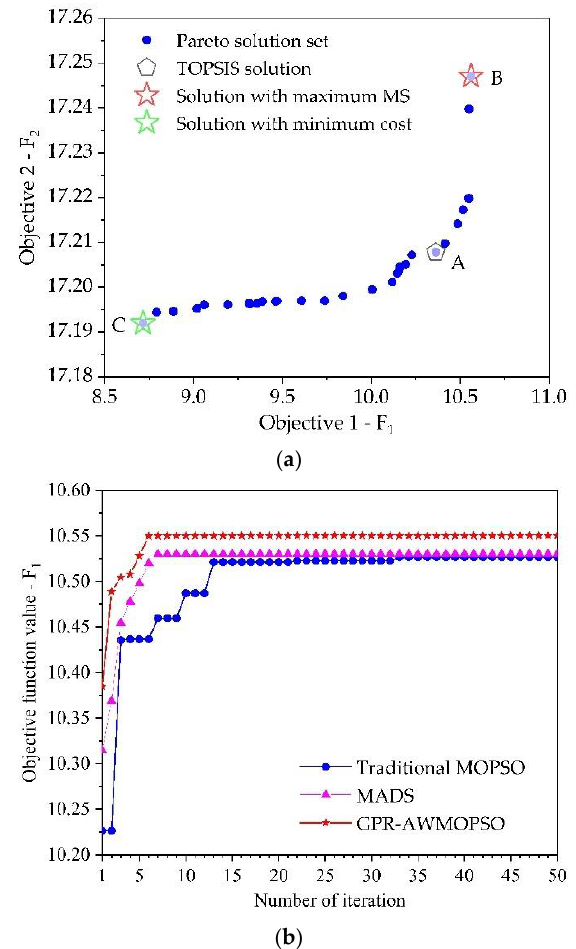
Figure 7. The proportion optimization results for basalt fibre modified asphalt mixture using GPR-AWMOPSO: ( a ) Pareto front showing two objectives (F 1 and F 2 ) and ( b ) the primary objective function value (F 1 ) versus iteration.